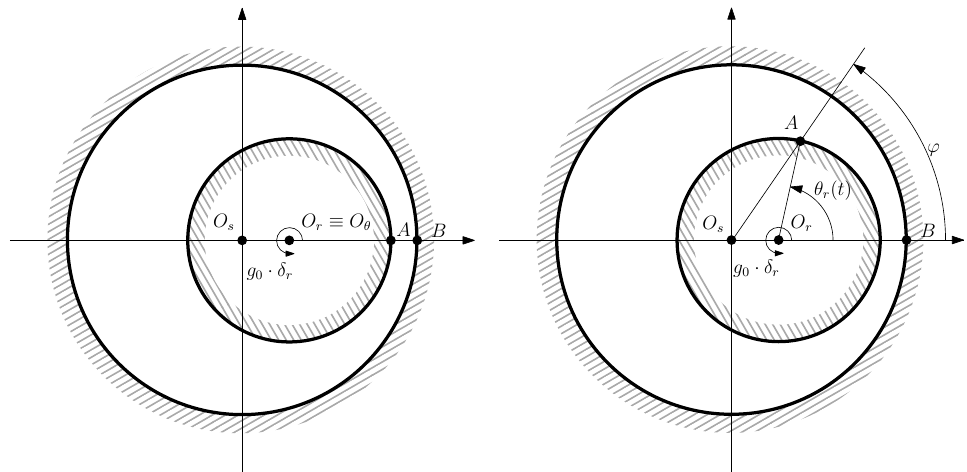
Figure 8. Pure static eccentricity. Relative position of a rotor conductor, A , and a stator conductor, B , when the rotor turns an angle θ r ( t ) ( right ) from the initial line ( left ), in the case of SE. The minimum air gap length is always located at the position of the stator conductor B